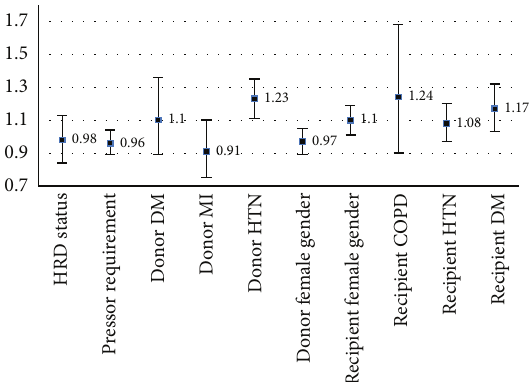
Table 1: Donor demographics.